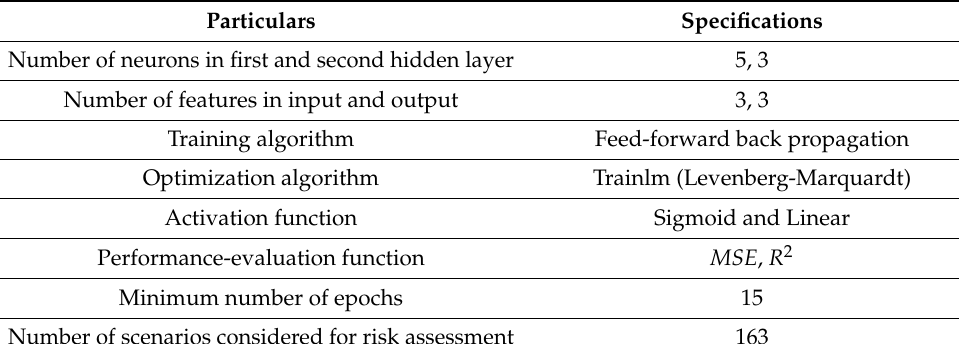
Figure 1. TRANCE framework development methodology. Table 2. Overview of the TRANCE